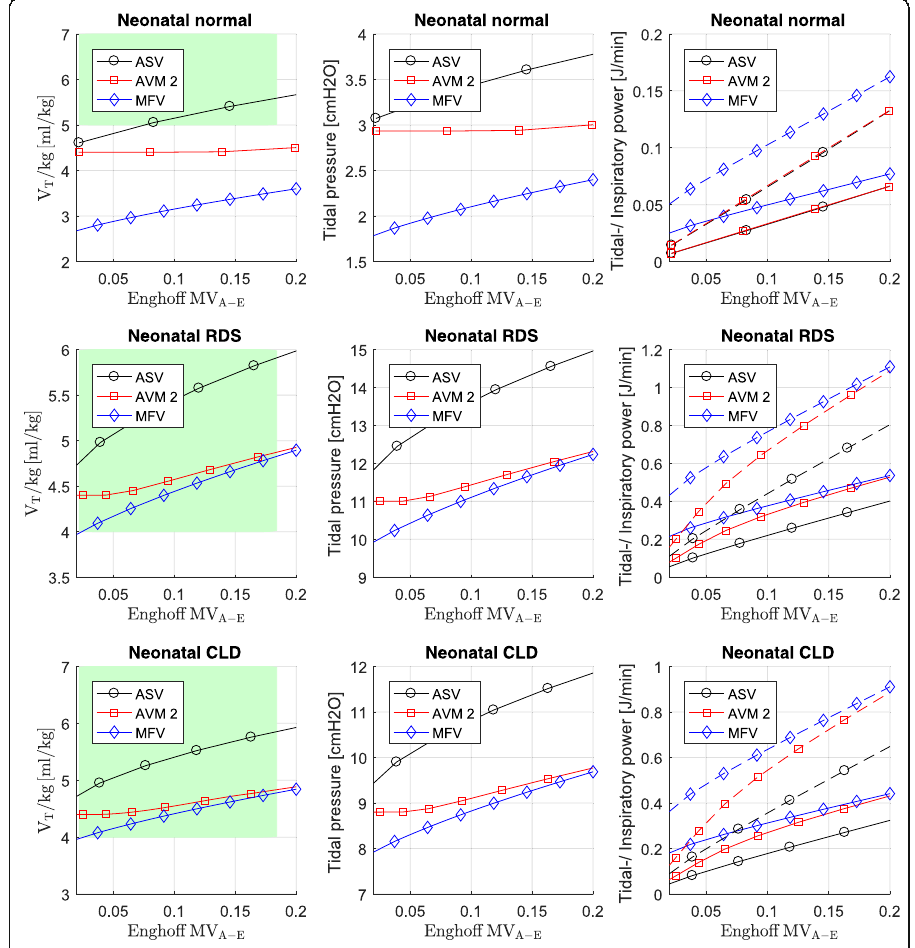
Fig. 4 Simulation results of neonatal normal, RDS, and CLD. Data points are optimum values for tidal volume, tidal pressure, tidal power (solid lines), and inspiratory power (dashed lines) for various levels of Enghoff alveolar minute ventilation (MV A-E ). The green area highlights the area which is normally used according to the work of McCann. For AVM2, it can be seen that the V T /kg ratio does not fall below 2·V D-A , which is the equivalent for minimal tidal power. For RDS, CLD, and normal simulation scenario, the concept of MFV yields the lowest tidal volumes and the concept of ASV yields the highest tidal